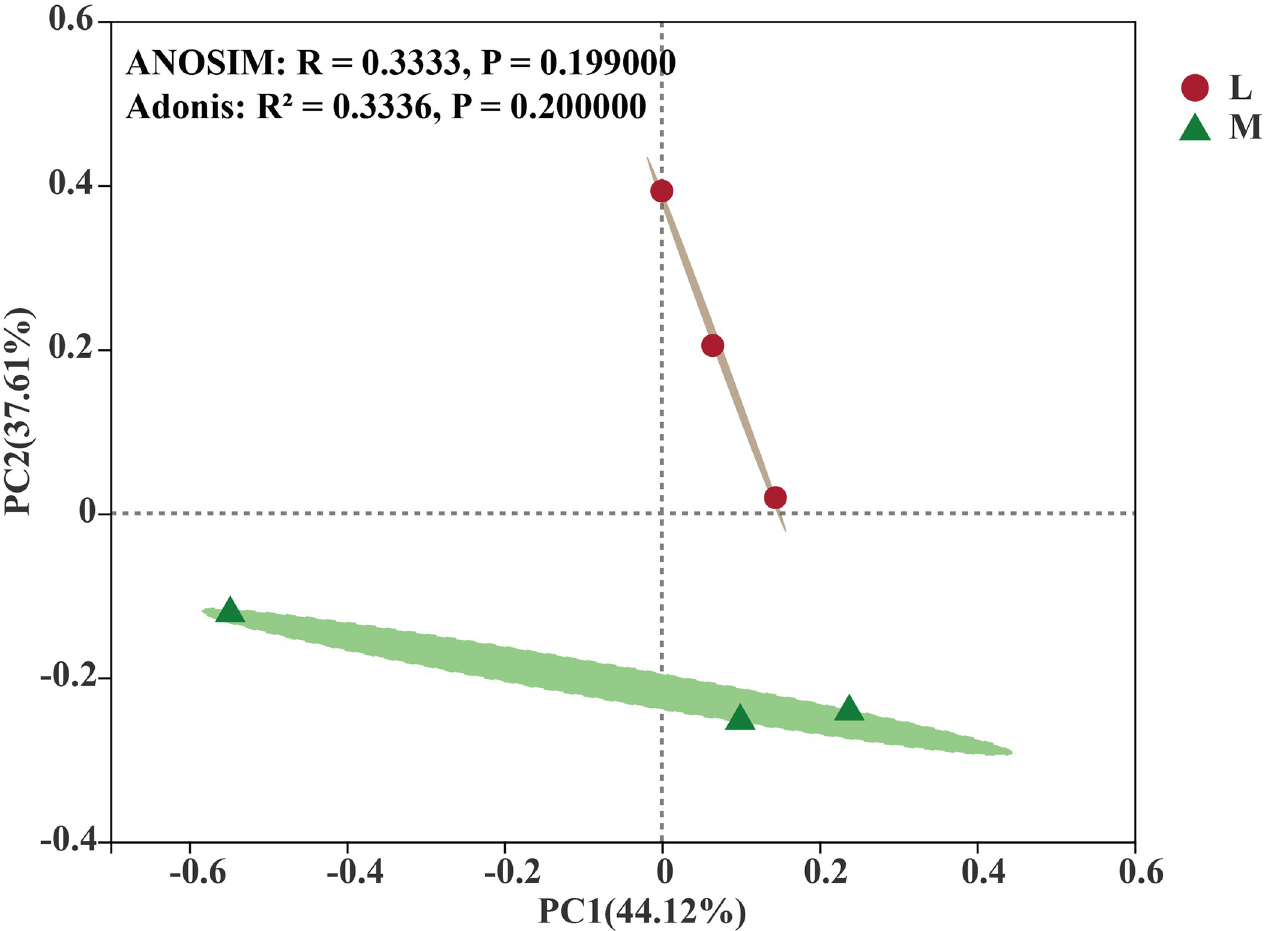
Fig 4. Principal coordinate analysis (PCoA) of soil bacterial communities between moss- and non-moss (L) growth (M) areas in litchi orchard based on Bray–Curtis distances.